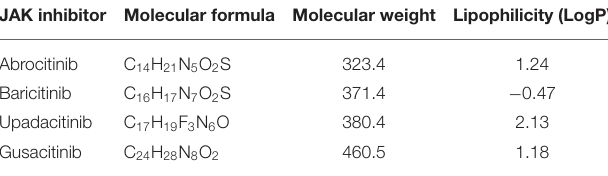
TABLE 3 | Summary of physicochemical properties of oral JAK inhibitors.